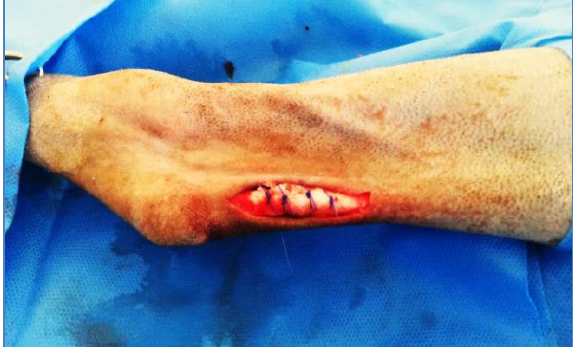
Figure, 4: Polypropylene mesh is fixed to the tendon core with simple interrupted stitches of polypropylene thread.